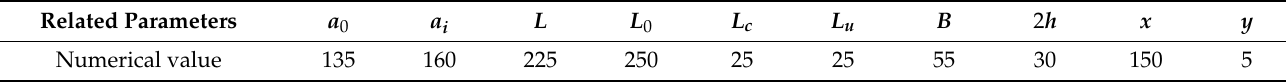
Figure 2. Schematic diagram of engineered-bamboo specimens. Table 3. Dimensional parameters of engineered-bamboo specimens (unit: